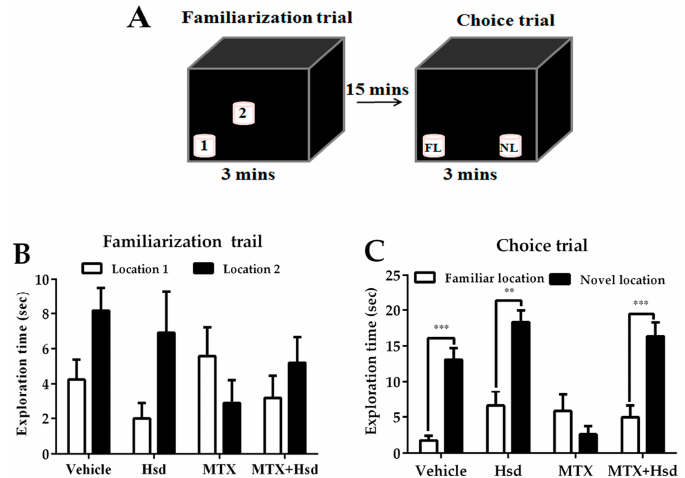
Figure 1. Schematic representation of the novel object location test ( A ). Mean exploration times (mean ± SEM) in the familiarization ( B ) and choice ( C ) trials of the novel object location test. All rats spent similar amounts of time exploring the objects placed in both locations 1 and 2 ( p > 0.05) in the familiarization trial. In the choice trial, the rats in the vehicle, Hesperidin (Hsd), and Methotrexate (MTX) + Hsd groups spent a significantly longer period of time investigating the object in the novel location when compared to the object in the familiar location (** p < 0.01, *** p < 0.001), but the rats receiving MTX alone did not ( p > 0.05). FL: Familiar location; NL: New location.